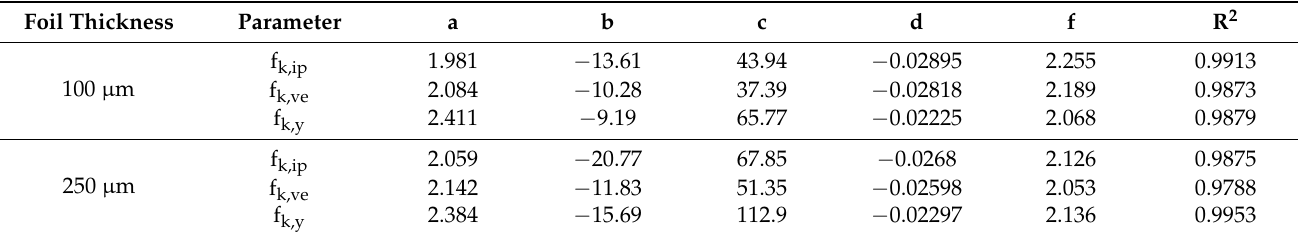
Table 4. Derived characteristic model parameters describing the temperature and strain rate depen- dence of f ve and f y (MPa) of ETFE